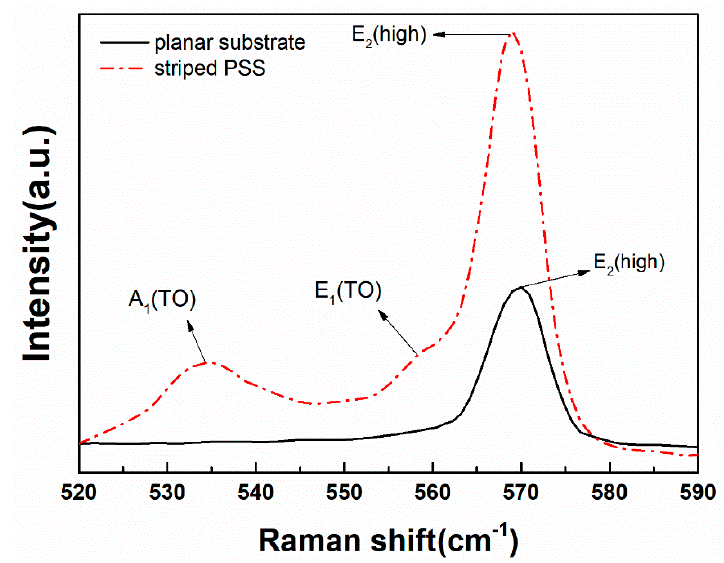
Figure 5. Raman spectra of GaN-based LED films grown on striped PSS and planar substrate.